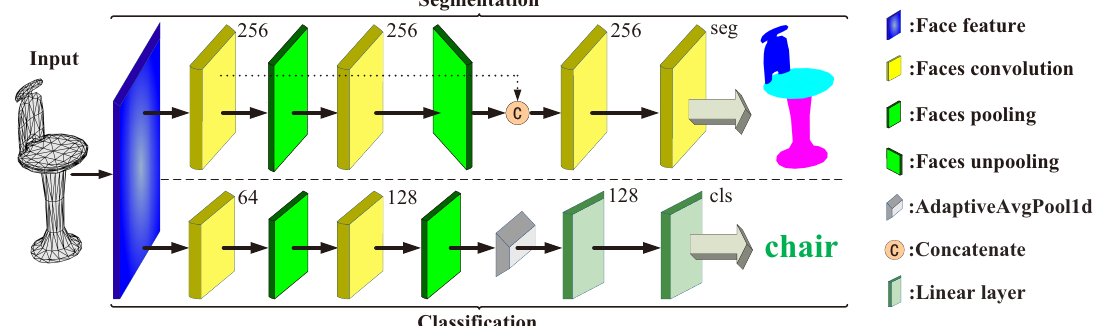
Figure 6. The architecture of the network for segmentation and classification, where the top of the block is the number of output channels for the